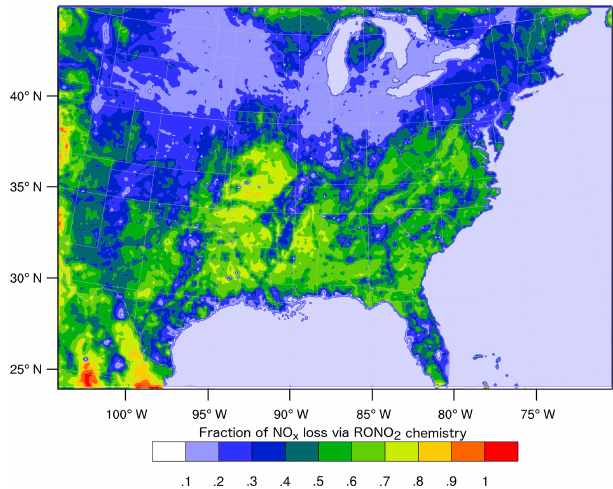
Figure 1. Average (24h) fraction of total NO x loss via RONO 2 chemistry over the southeast United States in summer 2013 sim- ulated using the RACM2_Berkeley2 mechanism in WRF-Chem (Zare et al.,